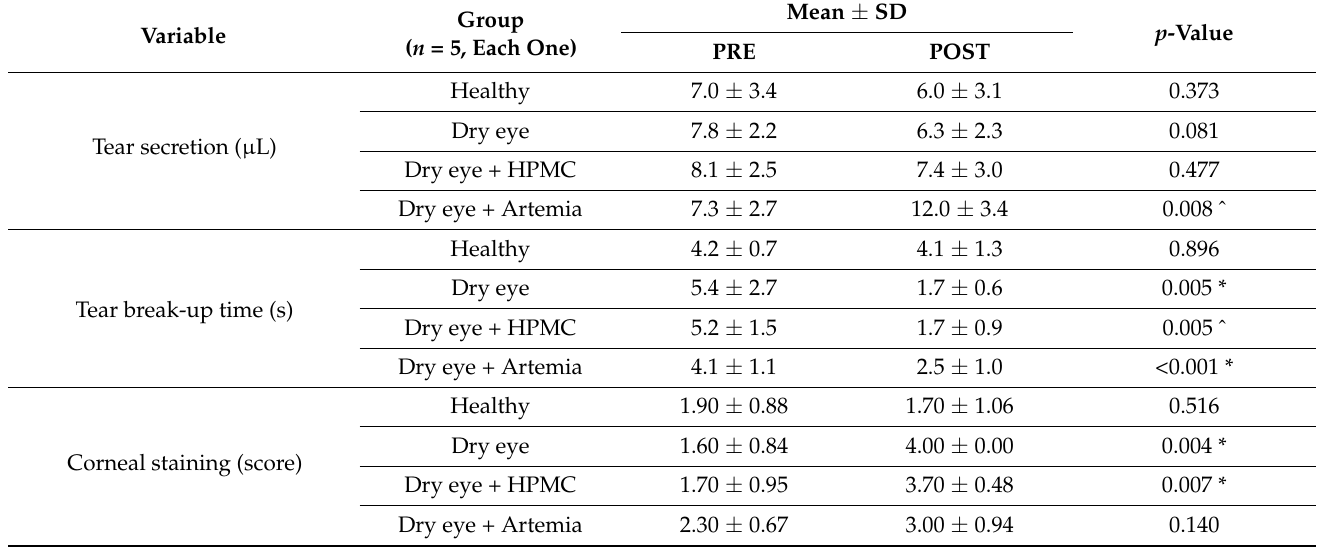
Table 1. Values of all the variables under study before (PRE) and after (POST) the instillation of the different treatments for 5 consecutive days. The statistical comparison was performed between the values PRE and POST in each group. Variable